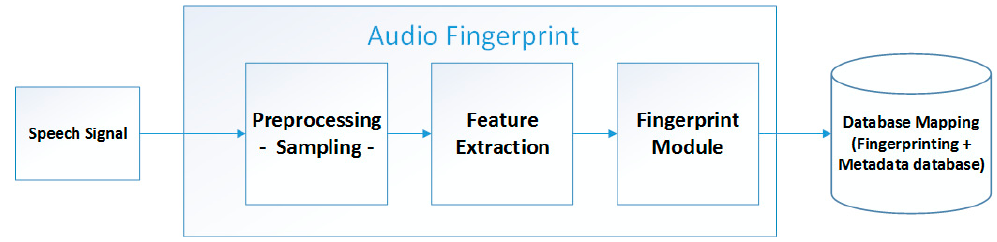
Figure 3. Sound/Speech Recognition System.